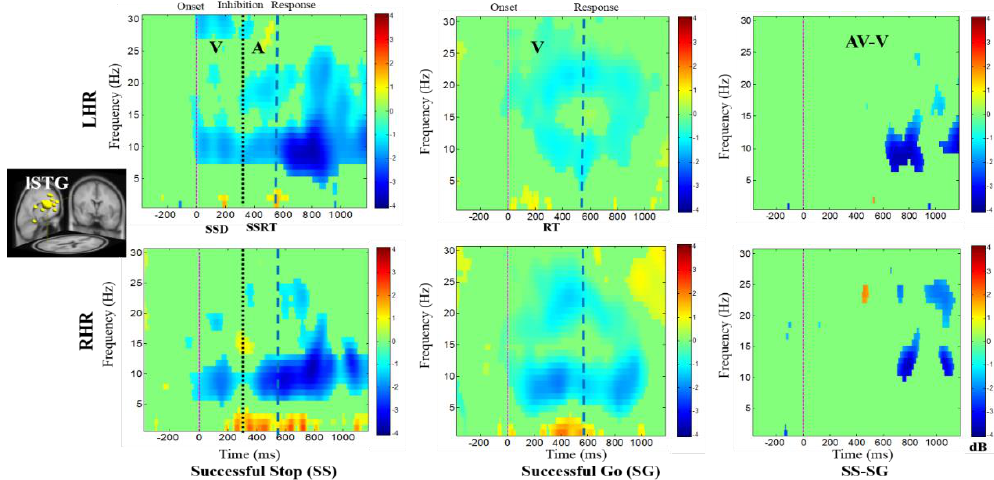
Figure 7. The ERSP plots showing the post-stimuli modulations in left superior temporal gyrus (lSTG) of the brain under combined visual (V) stimuli and auditory (A) alarms. Purple dashed line: Onset of the visual stimuli; black dashed line: Onset of the auditory alarms; blue dashed line: Onset of response. Color bars show the amplitude of the ERSP; statistical threshold at p < 0.01.